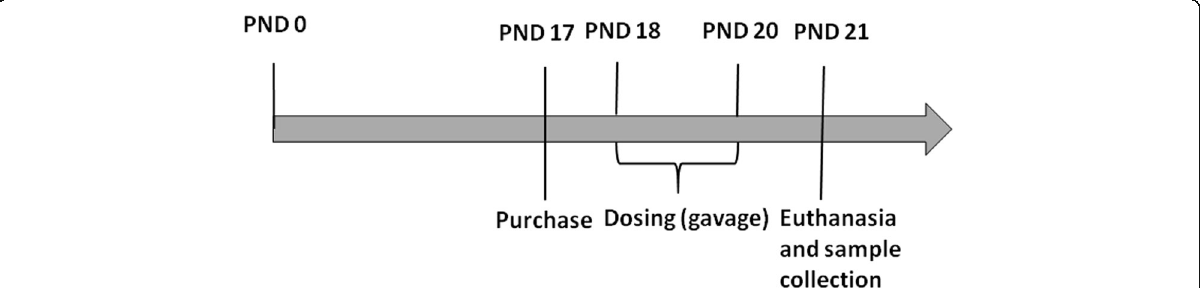
Fig. 1 Schematic of the experimental design adopted for soes-response analyses of the individual chemicals and their mixtures. PND was the day of